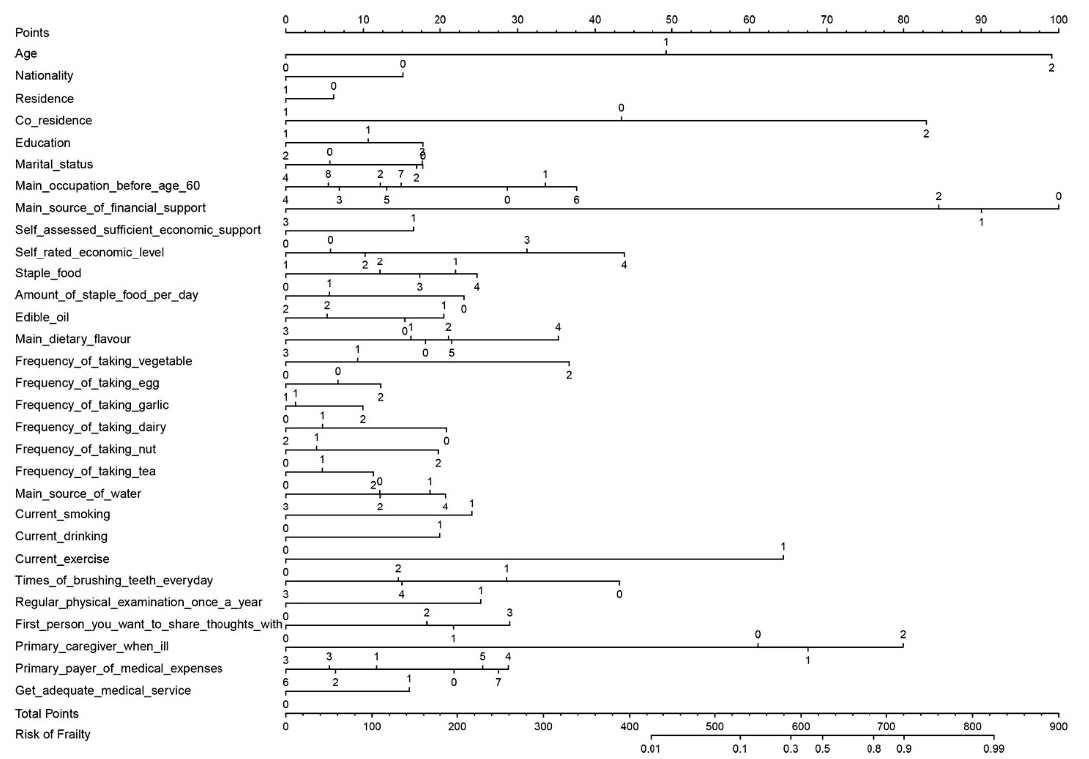
Figure 1. A nomogram to predict frailty risk of older adults.